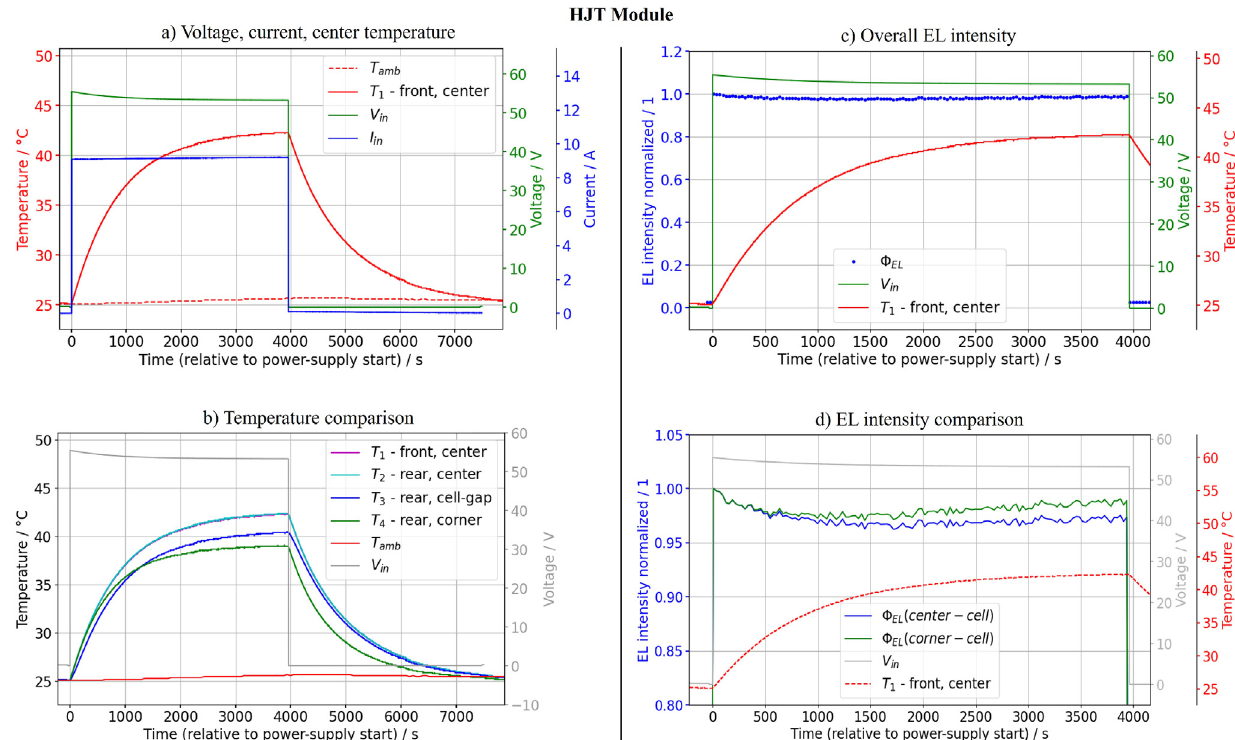
Fig. 3. Experimental results of HJT module. Voltage, current and centered cell temperature (a), comparison of all temperatures measured (b), evolution of the electroluminescence signal over measurement time (c) and comparison of two electroluminescence signals measured for a center and a corner cell of one module (d).